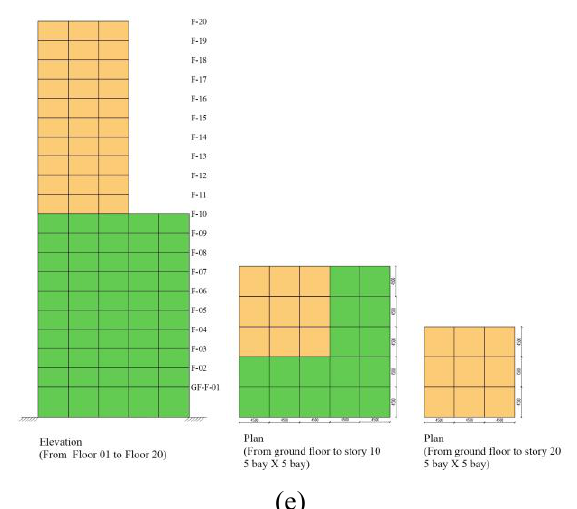
Fig. 3. Plan and elevation of the 5 types of buildings.